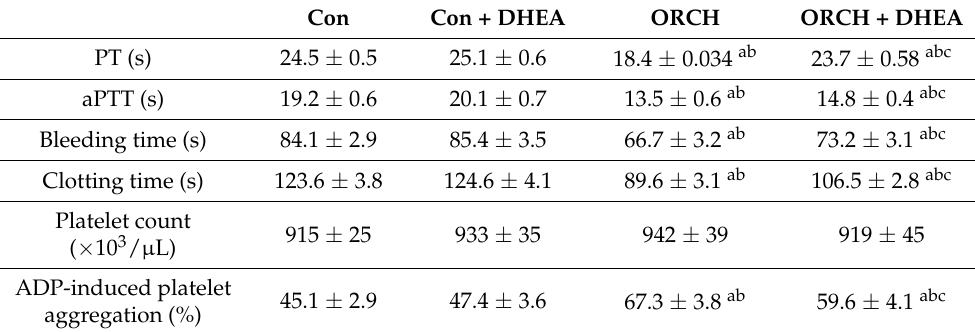
Table 3. Bleeding time, clotting time, PT, aPTT, platelets count, and ADP-induced platelet aggregation (%) in control and orchidectomized